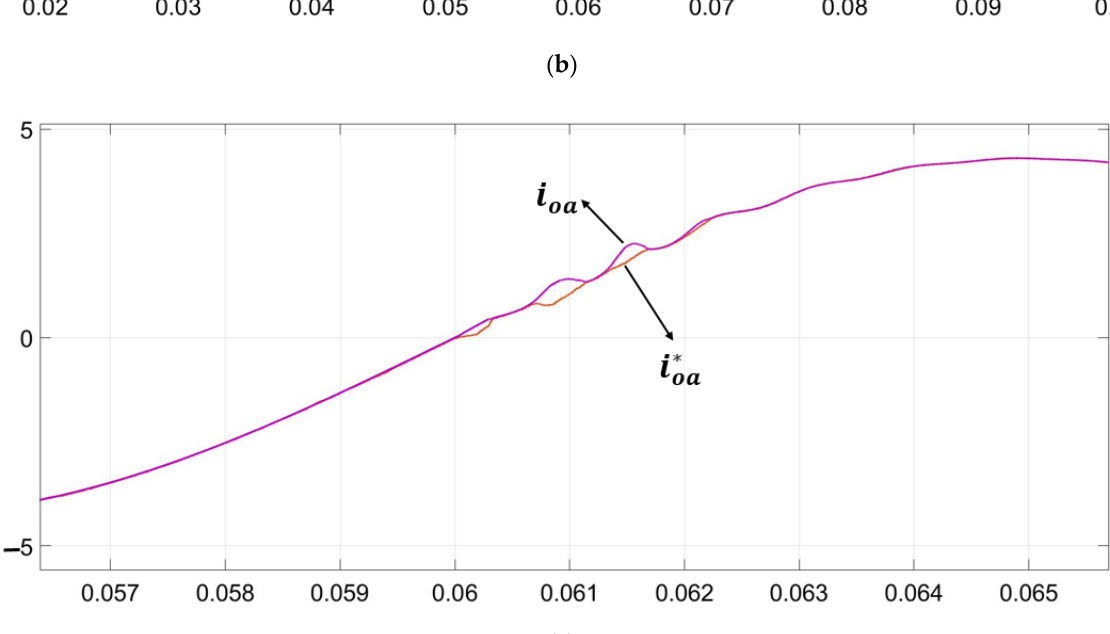
Figure 7. Simulation results of the VMMPC for the TSMC, and output-current frequency reference is set to 50 Hz: The IFRS is added at t = 0.06 s, x-axis unit second: ( a ) source voltage V sA /13 V, source current i sA A and source-current reference i sA * A; ( b ) output current i oa A and output-current reference i oa * A; ( c ) details of the box in Figure 7b.